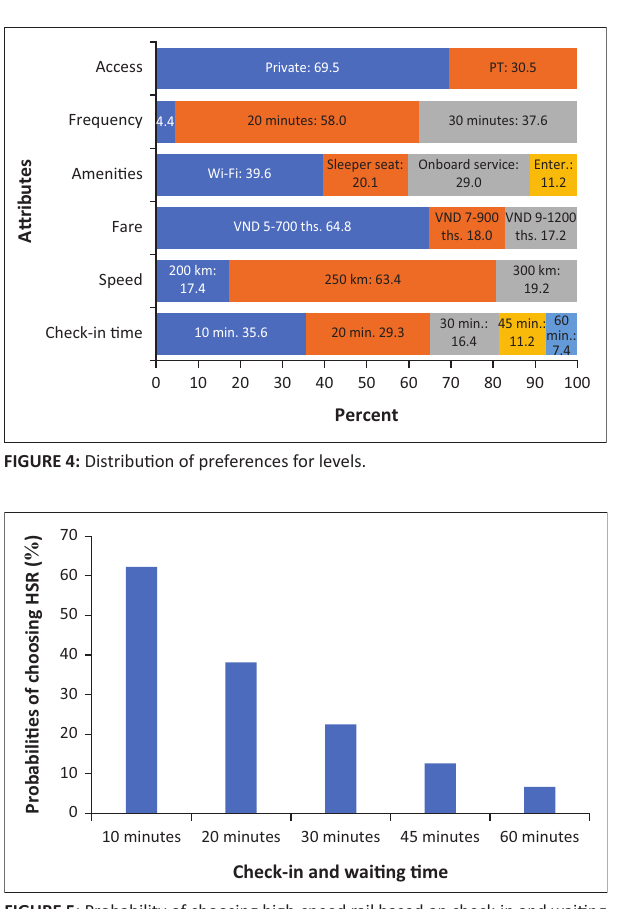
FIGURE 5: Probability of choosing high-speed rail based on check-in and waiting time.